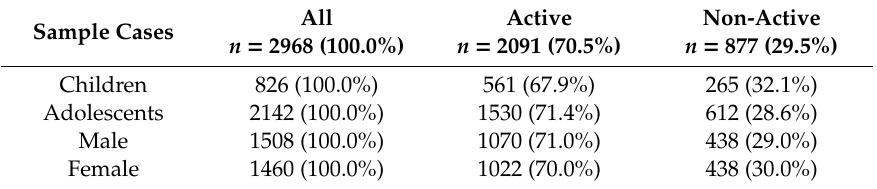
Table 1. Sample cases descriptive frequencies separately by participants’ subgroups.